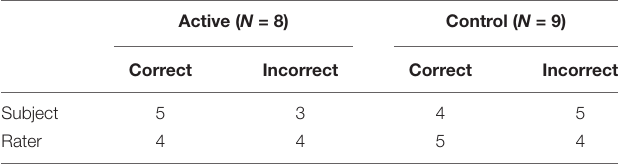
TABLE 4 | Number of subjects and raters correctly guessing group assignment after treatment and repeat